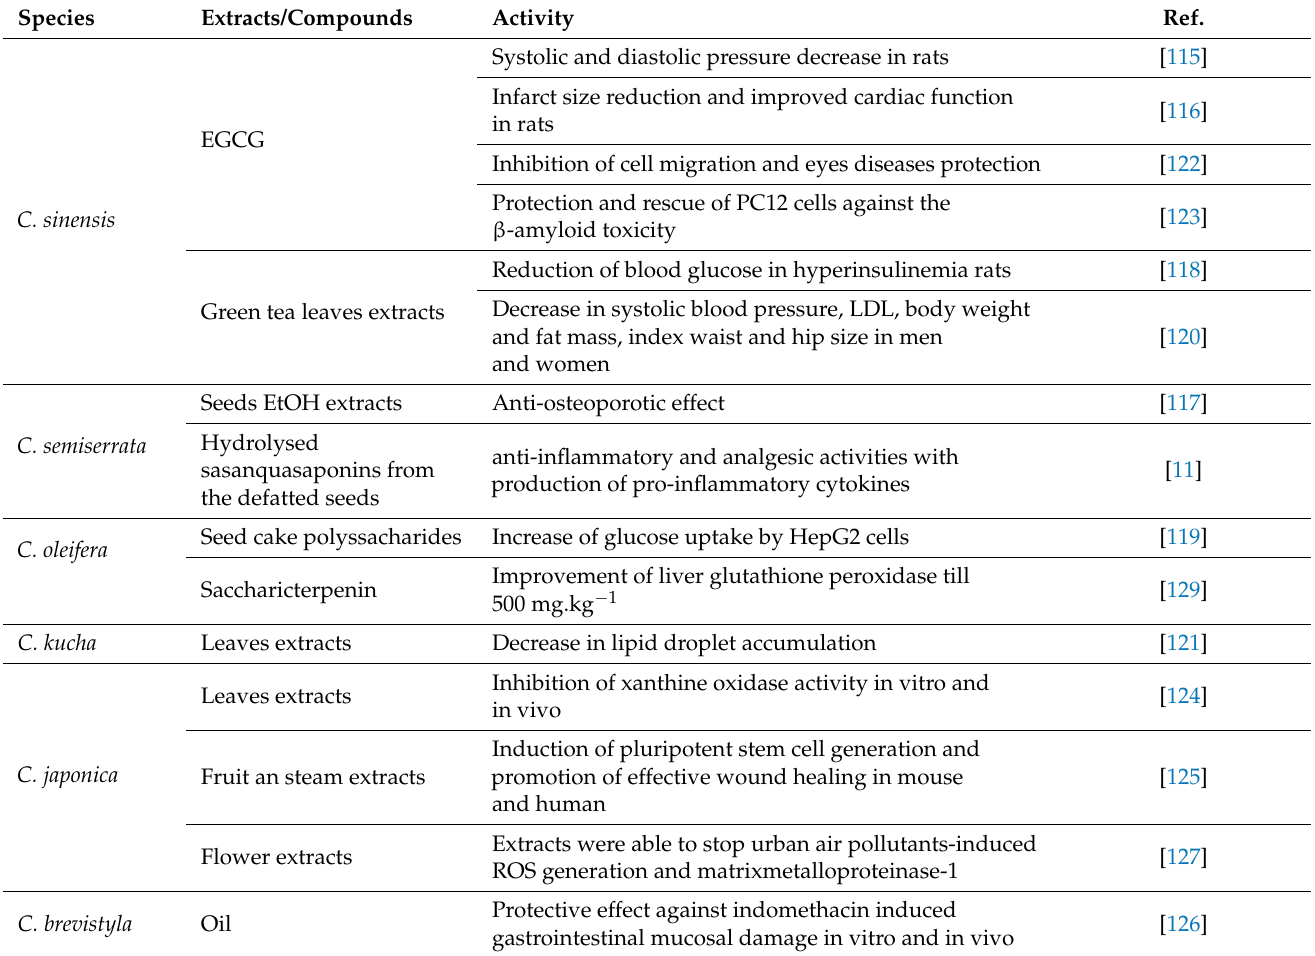
Table 4. General benefits on health and diseases of Camellia species